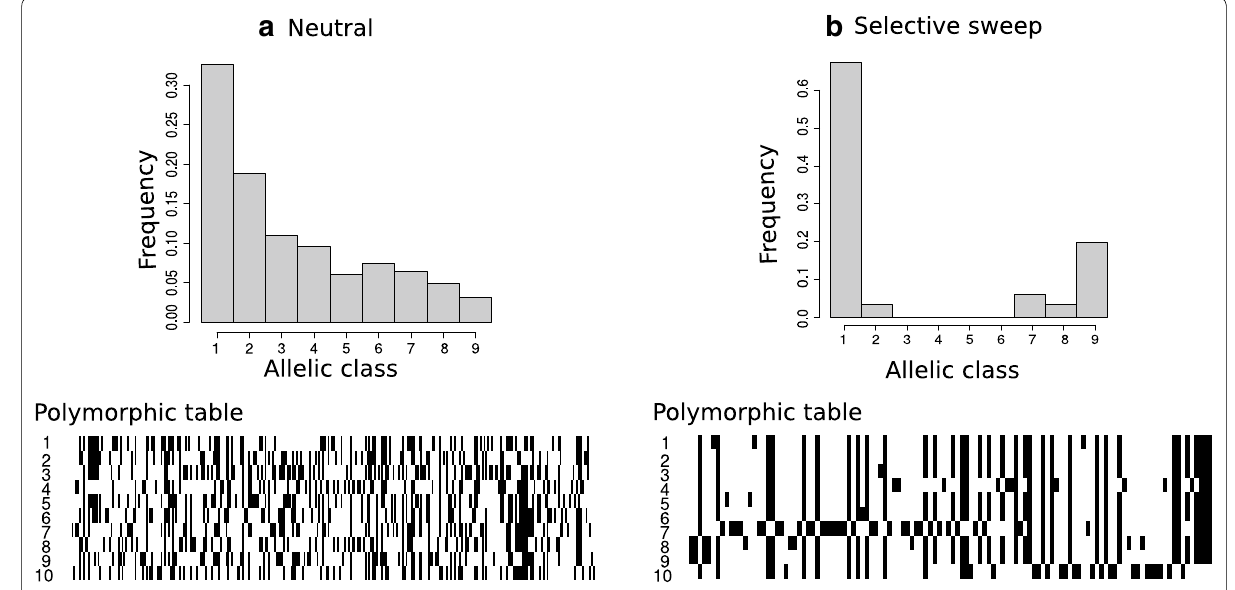
Fig. 1 The SFS signature of a selective sweep compared to the neutral SFS. In the polymorphic table, black cells denote derived alleles, whereas the white cells denote ancestral alleles. Each column in the polymorphic table represents a SNP. Monomorphic sites have been excluded. a Neutral SFS and its respective polymorphic table. b SFS after a selective sweep and its respective polymorphic